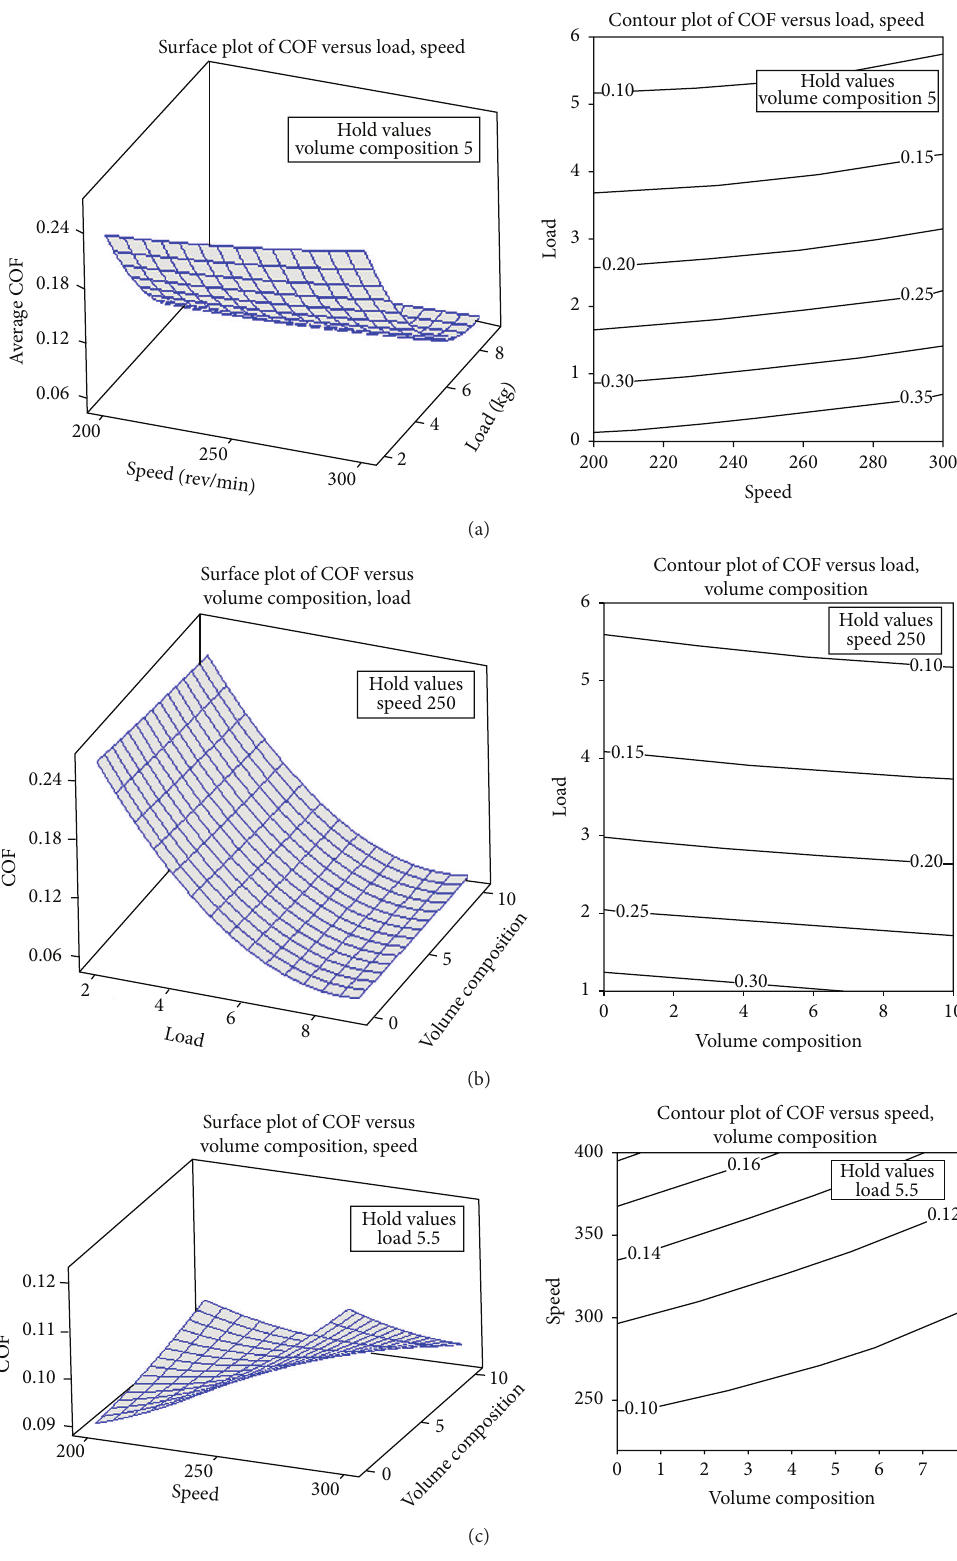
Figure 7: (a) Influence of load and speed on COF. (b) Influence of volume composition and load on COF. (c) Influence of volume composition and speed on